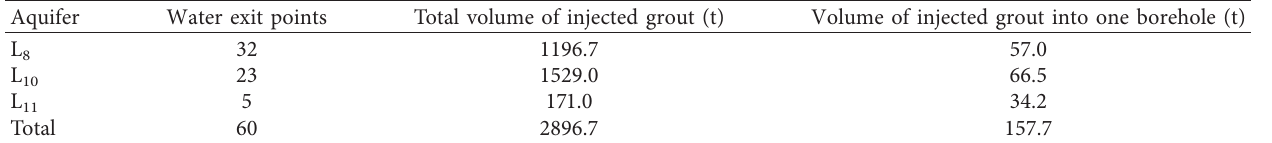
Table 7: Type IV fracture.